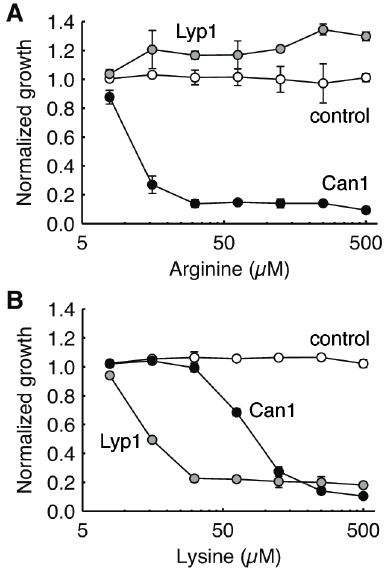
Figure 4. The effect of external arginine ( A ) and lysine ( B ) on the growth of strains overexpressing Can1 or Lyp1. BY4709 carrying the empty plasmid pRSII426 was used as a control. Can1 and Lyp1 were expressed from the constitutive ADH1 promoter with a C-terminal YPet tag. Normalized growth refers to cell density after 24 h, normalized to minimal media without amino acids. Values are the mean of biological triplicates. Error bars represent standard deviation and, in some cases, are obscured by the data point.